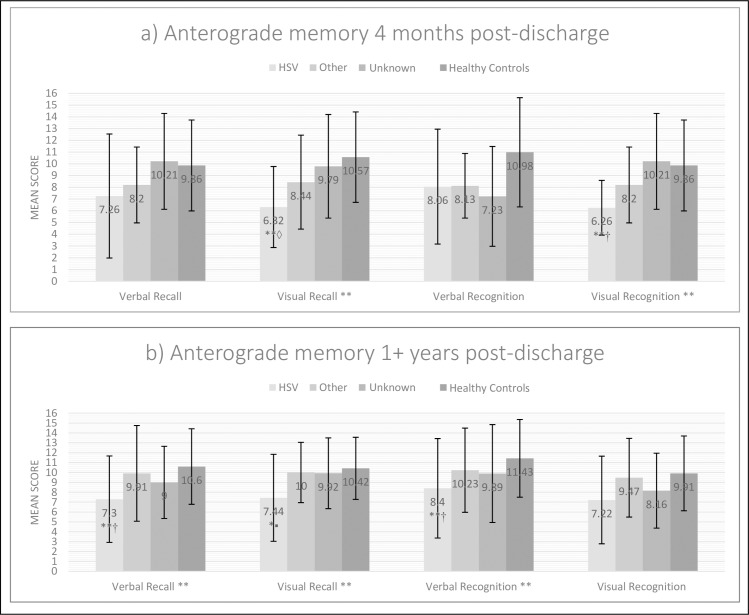
Mean anterograde memory scores for each aetiological group (Doors & People test).The error bars represent the standard deviation of the mean score within each group. (a) At the short-term assessment, a mean of 4 months post-discharge (in the short- and medium-term outcome cohort) and (b) at the long-term assessment, at least 1 year post-discharge (in the long-term outcome cohort). Notations: *p≤0.05, **p≤0.01; † Hochberg GT2/Games-Howell post hoc (parametric); ▪Bonferroni-corrected pairwise analysis (ANCOVA post hoc). ◊ Mann Whitney U post hoc (non-parametric).